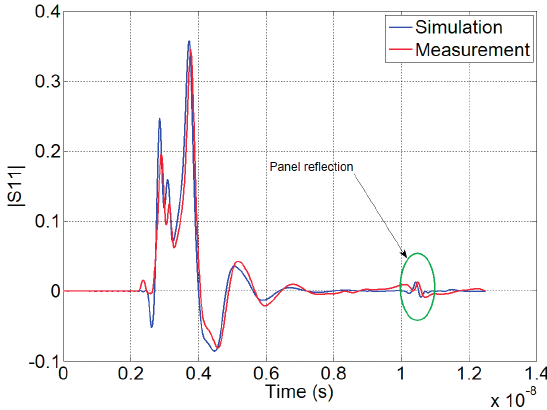
Figure 5. Reflection of the metallic panel: comparison between the simulation and the